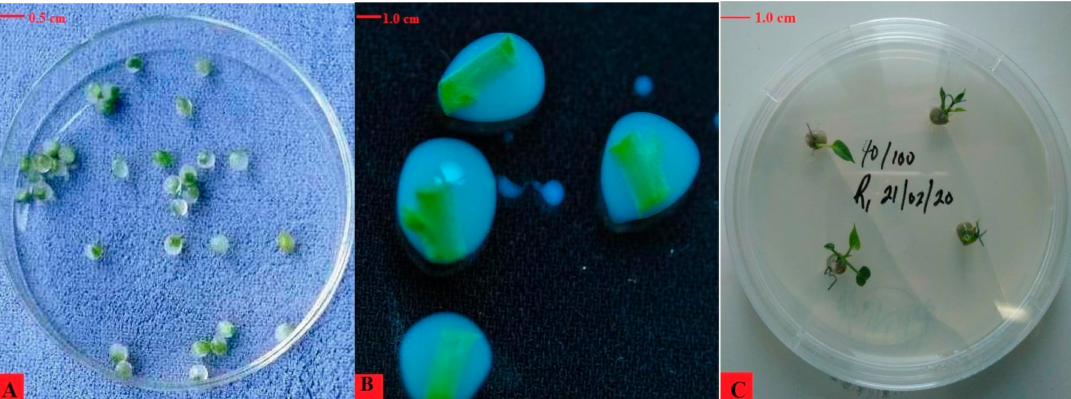
Figure 2. Encapsulated nodes of vegetable sweet potato ( Ipomoea batatas L.) at different development stages. Single nodal segments of sweet potato encapsulated with sodium alginate and CaCl 2 ( A , B ), growing sweet potato plantlets at three weeks after inoculation into MS medium before transferring to a new MS medium ( C